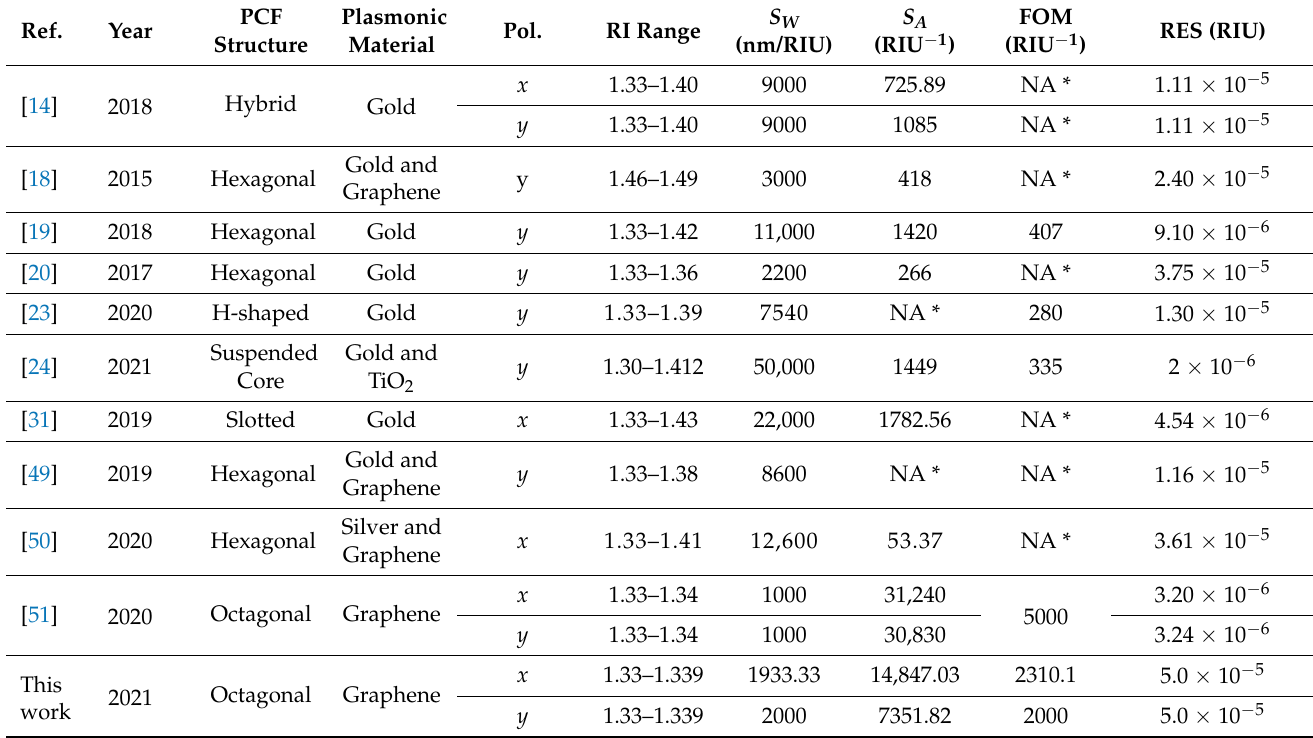
Table 3. Comparative study between the proposed and other reported SPR sensors.